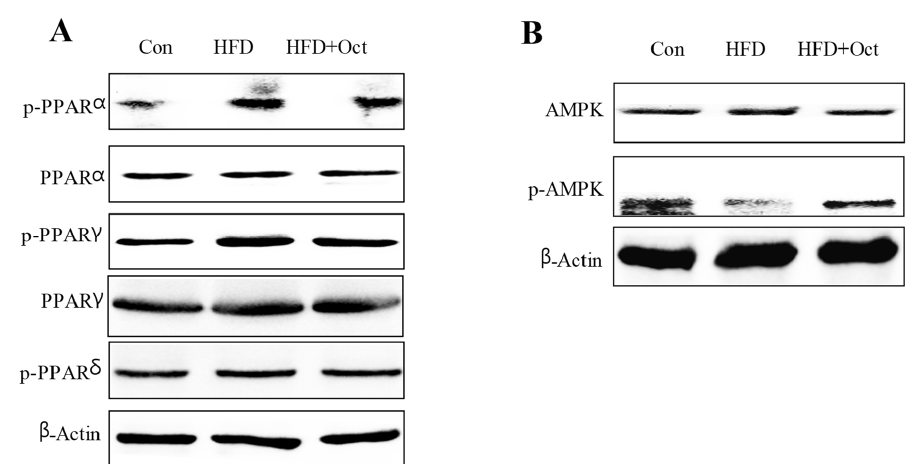
Figure 10. Octacosanol regulated PPAR and AMPK signal pathways in liver tissues. ( A ) Octacosanol regulated the PPAR signal pathway as analyzed by WB (triple duplicate experiments). ( B ) Octacosanol regulated the AMPK signal pathway as analyzed by WB (triple experiments). Oct, octacosanol; HFD, high-fat diet. Octacosanol regulated PPAR and AMPK signal pathways in liver tissues.